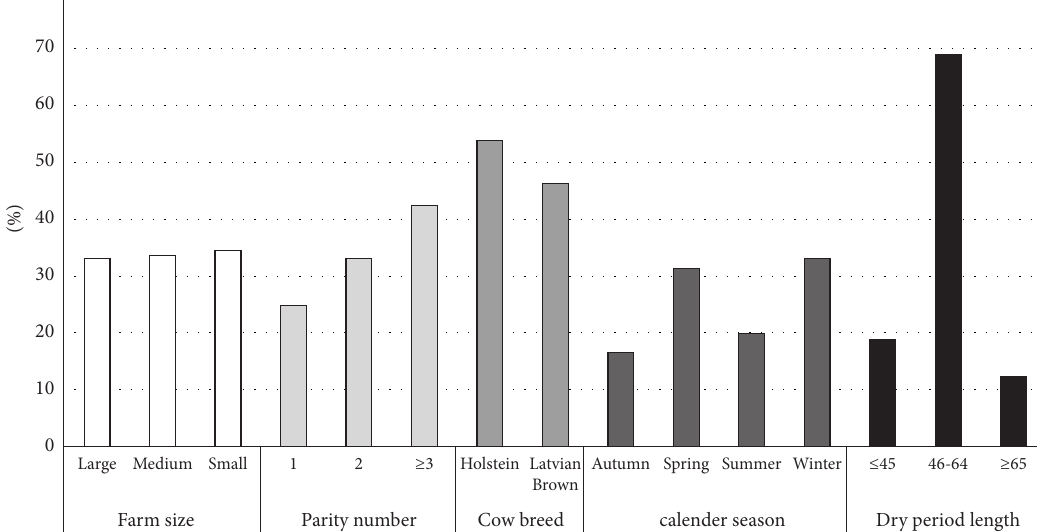
Figure 1: The proportion of categories of explanatory variables describing examined fecal samples of